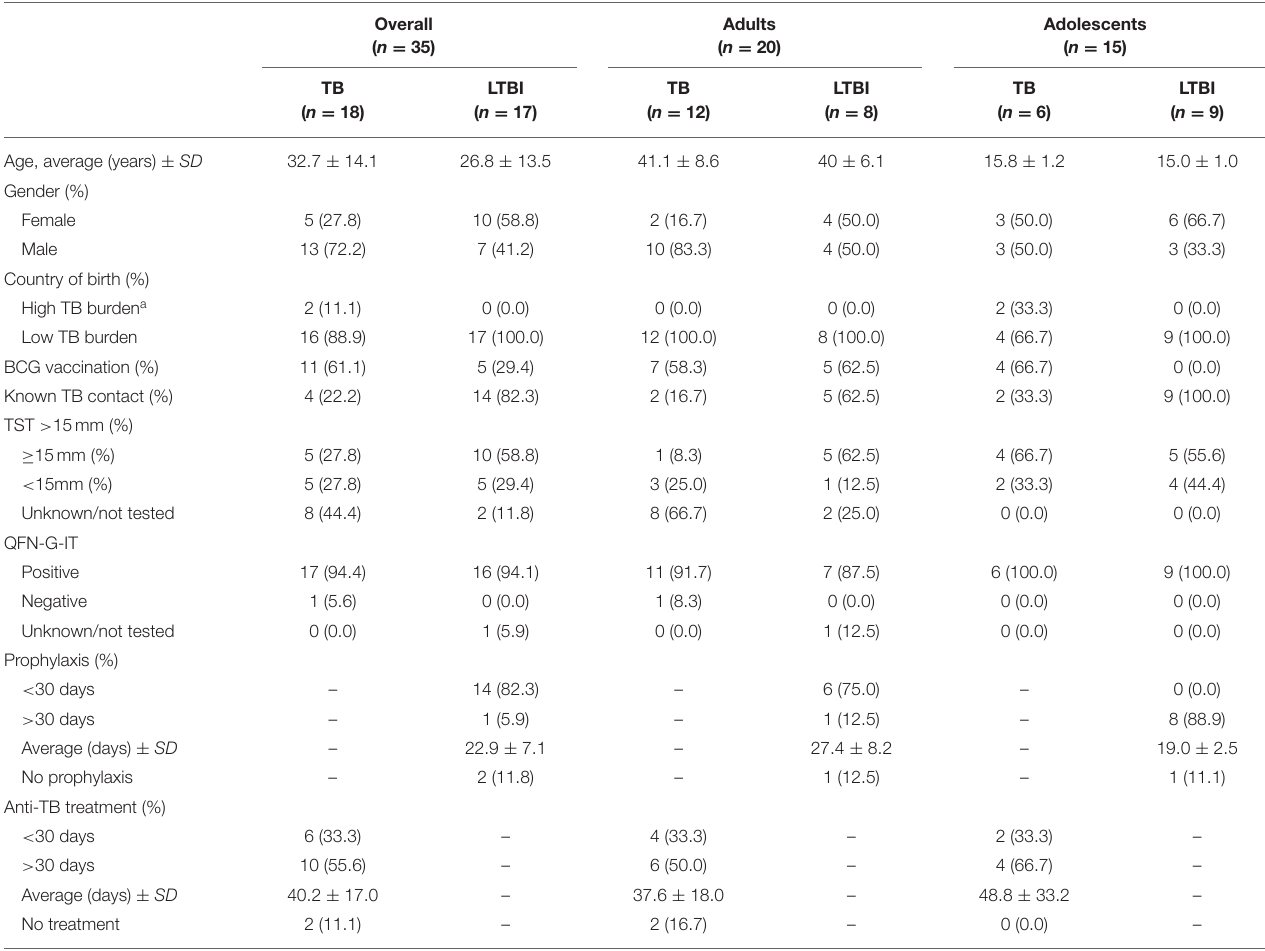
TABLE 1 | Demographic and clinical characteristics of all patients included in the